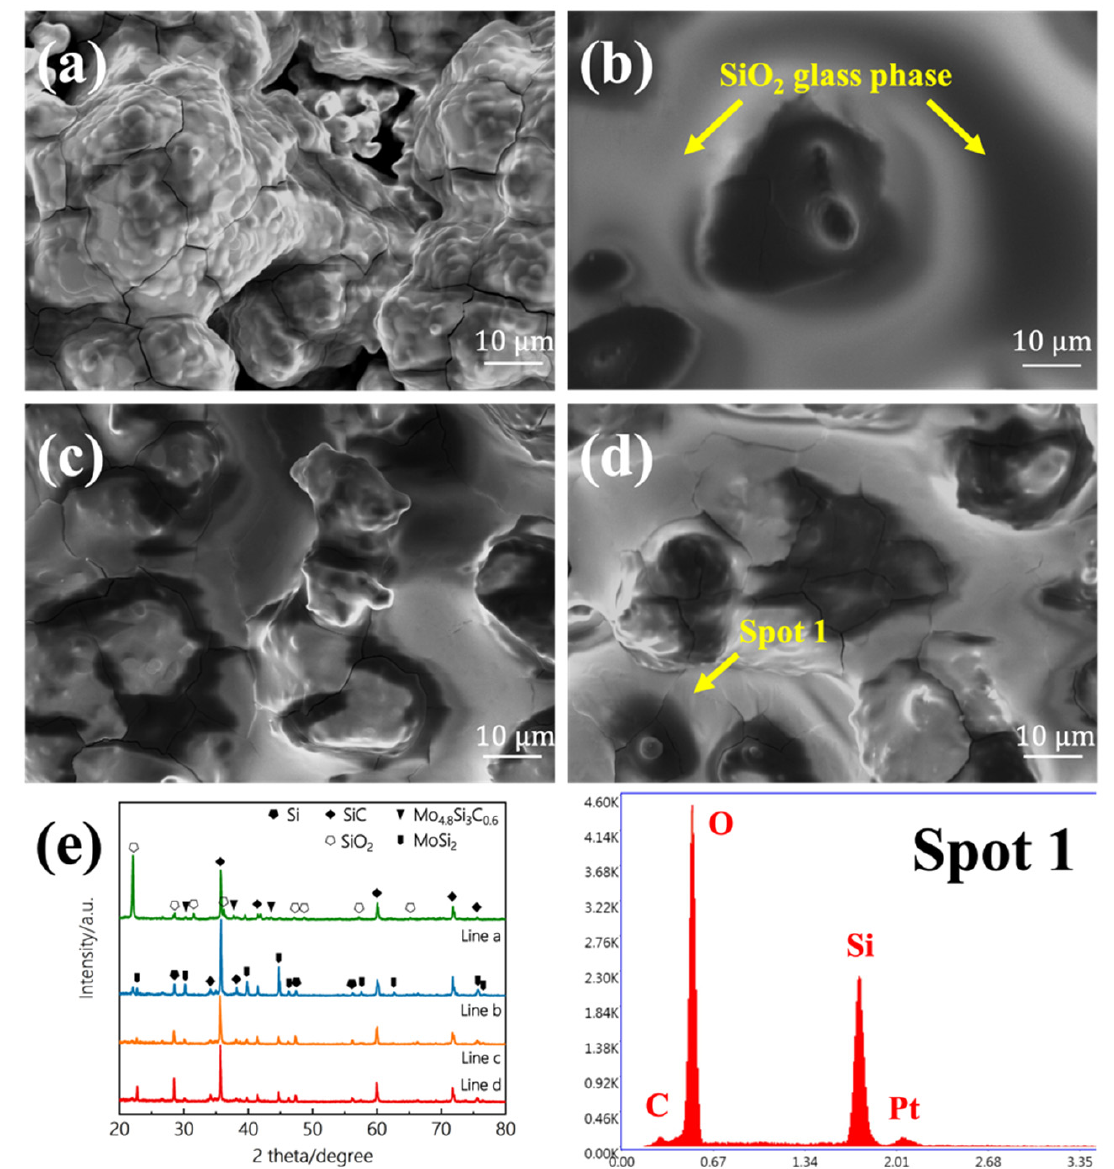
Figure 5. SEM images of the surface of SiC/MoSi 2 -SiC-Si coatings after oxidation with different Si/Mo ratio: ( a ) 1:1, ( b ) 3:1, ( c ) 5:1, ( d ) 7:1. ( e ) XRD patterns of the SiC/MoSi 2 -SiC-Si coatings after oxidation with different Si/Mo ratio: a, 1:1; b, 3:1; c, 5:1; d, 7:1.